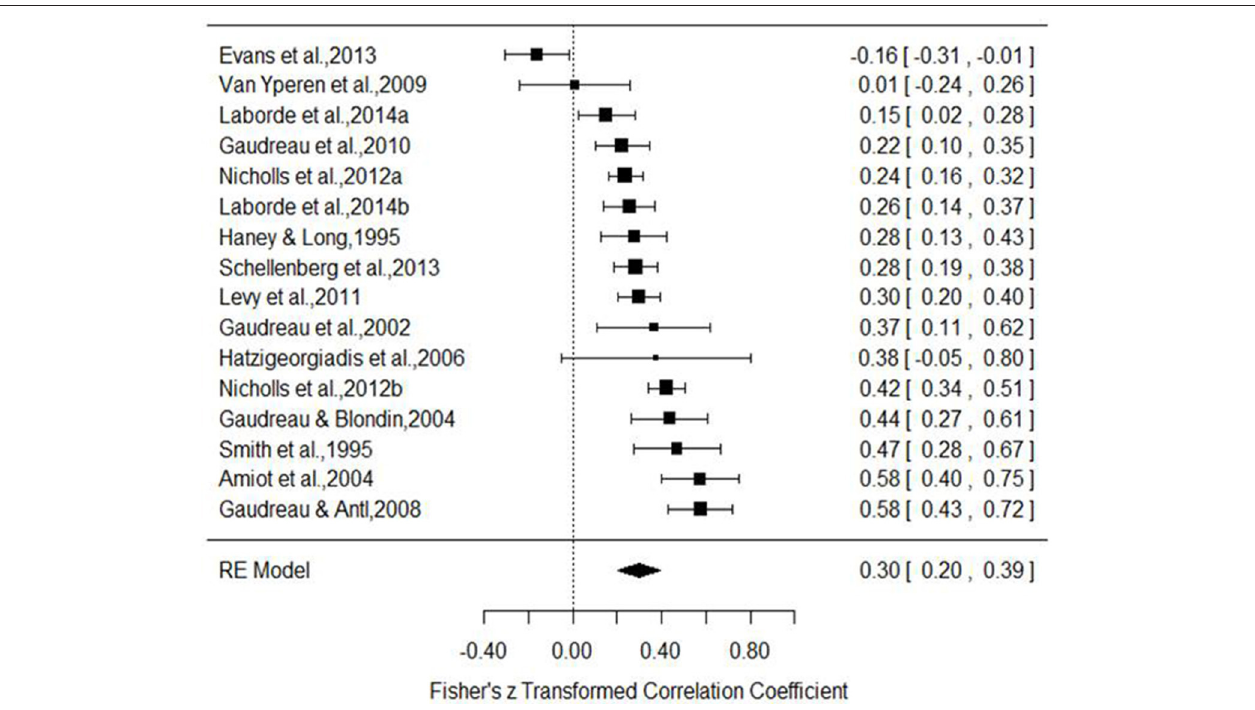
FIGURE 2 | Mastery coping forest plot. (Haney and Long, 1995; Smith and Christensen, 1995; Gaudreau et al., 2002, 2010; Amiot et al., 2004; Gaudreau and Blondin, 2004b; Hatzigeorgiadis, 2006; Gaudreau and Antl, 2008; Van Yperen, 2009; Levy et al., 2011; Nicholls et al., 2012a,b; Schellenberg et al., 2013; Evans et al., 2014; Laborde et al., 2014a,b ).